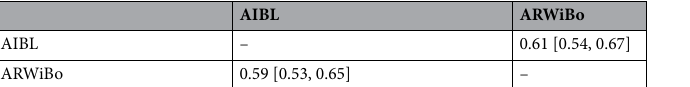
effective in generating deviation values that reflect the severity of the disease, with patients with AD showing higher deviations than patients with MCI, and patients with LMCI showing larger deviations than patients with EMCI. We also measured how much each brain region deviated from normality and contributed to the observed deviation. Here, we found that regions from the ventricular system and medial temporal lobe were among those making the greatest significant contribution to deviation, consistent with our second hypothesis. Finally, we compared the performance of the normative approach versus a traditional classification approach. Although a higher performance was found for traditional classifiers in most cases, the difference was not statistically sig- nificant in the majority of cases. We have replicated previous findings that the autoencoder is capable of detecting neuroanatomical deviation in individuals with brain disorders 5 . In particular, in each of our five independent datasets, the normative model was able to assign higher values to patients with AD than healthy controls. This pattern was expected since the disorder is associated with profound alterations in the brain morphometry which were not present in the training set 13, 14 . In addition, we have expanded these findings by demonstrating for the first time that autoencoders are